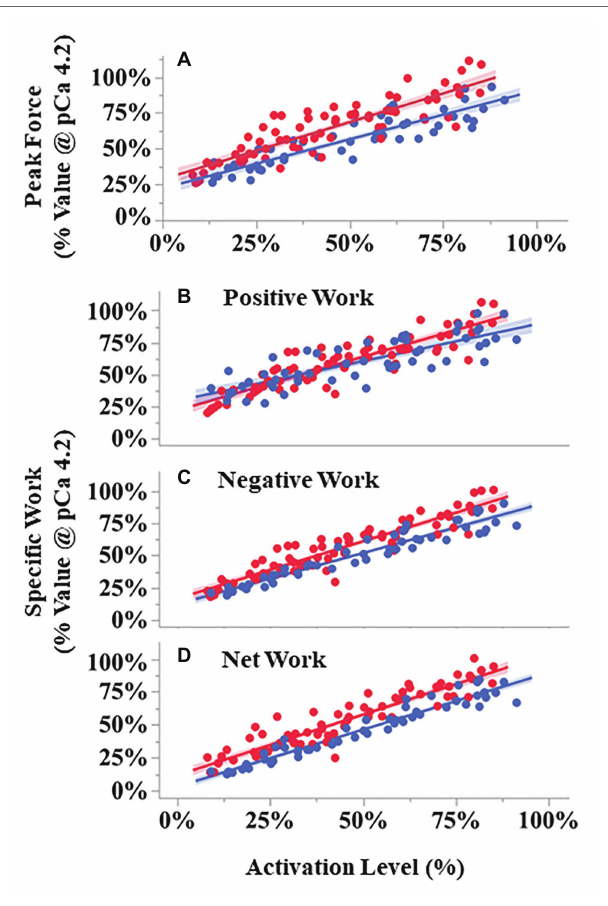
FIGURE 6 | Peak force and work during SSCs vs. activation level for pCa- (blue) and BDM- (red) controlled fibers. All variables scaled linearly with activation level analysis of covariance (ANCOVA covariate effect < 0.001). Peak forces (A) were larger in BDM- vs. pCa- controlled trials across activation levels ( p = 0.0014). Both negative ( p < 0.001) and total work ( p = 0.014) components were also larger in BDM vs. pCa controlled fibers. Compared to pCa-controlled trials, BDM-controlled trials had a modest but statistically significant steeper increase with activation level for positive work ( B , ANCOVA interaction effect, p = 0.0072) and negative work ( C , p = 0.031), but not for net work ( D , p = 0.16). The 95% CIs are shown by the shaded regions around the lines. N = 15 pCa and 16 BDM experiments, n = 52 pCa and 76 BDM